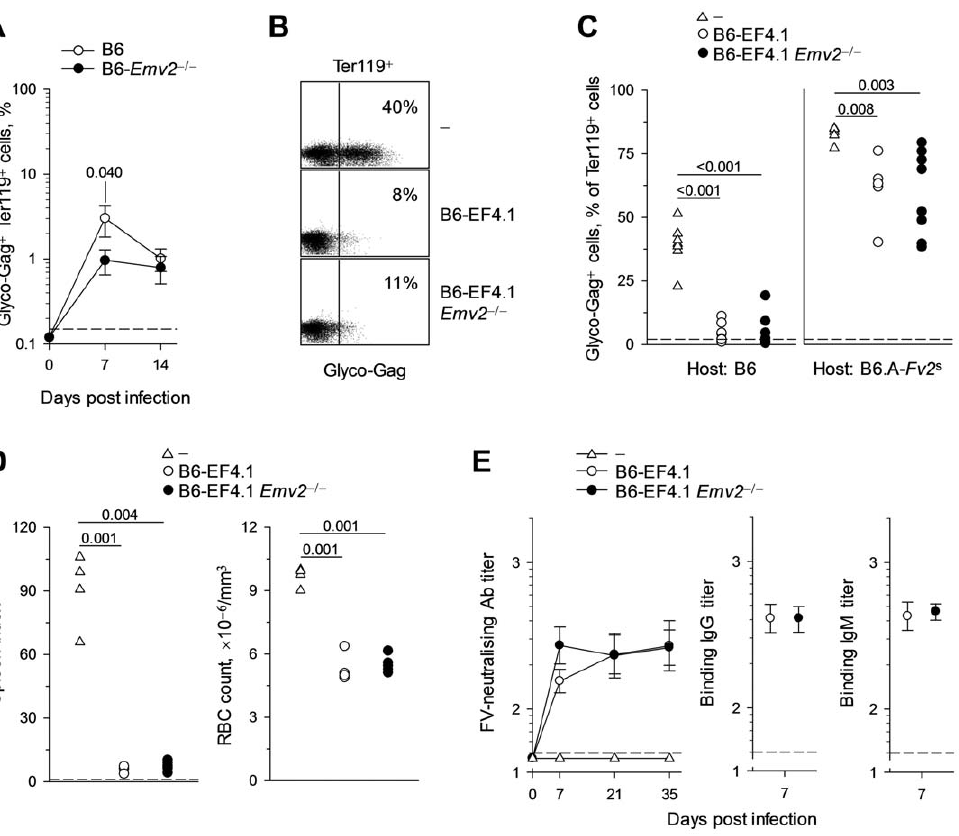
Figure 3. Emv2 -selected CD4 + T cells retain full antiviral activity. (A) Mean frequency ( 6 SEM, n =8–19) of FV-infected (glyco-Gag + ) Ter119 + cells in the spleens of FV-infected B6 or Emv2 -deficient B6 mice (B6- Emv2 2 / 2 ). (B–C) CD4 + T cells isolated from either B6 (B6-EF4.1) or Emv2 -deficient B6 (B6-EF4.1 Emv2 2 / 2 ) EF4.1 mice were adoptively transferred into B6 or B6.A- Fv2 s recipients that were infected with FV the same day and analyzed 7 days later. (B) Flow cytometric example of FV-infected Ter119 + cells from B6 recipients and (C) frequency of FV-infected cells in Ter119 + cells from the spleens of B6 or B6.A- Fv2 s recipients of CD4 + T cells. Control B6 and B6.A- Fv2 s mice that received no CD4 + T cells (-) are also included. Each symbol is an individual mouse. (D) Spleen index ( left ) and RBC count ( right ) of B6- Rag1 2 / 2 Fv2 s mice that were infected with FV and either received the same day CD4 + T cells isolated from either B6 (B6-EF4.1) or Emv2 -deficient B6 (B6-EF4.1 Emv2 2 / 2 ) EF4.1 mice or no cells (-). Each symbol is an individual mouse analyzed 3 weeks post infection. (E) Titers of FV-neutralizing antibodies during the course of FV infection ( left ) and titers of F-MLV-infected cell- binding IgG ( middle ) and IgM ( right ) 7 days post FV infection, in the sera of B6- Tcra 2 / 2 mice that either received CD4 + T cells isolated from either B6 (B6-EF4.1) or Emv2 -deficient B6 (B6-EF4.1 Emv2 2 / 2 ) EF4.1 mice or no cells (-) the day of the infection. Dashed lines represent the limit of detection. Data are the means 6 SEM ( n =11–12) from 2 experiments.